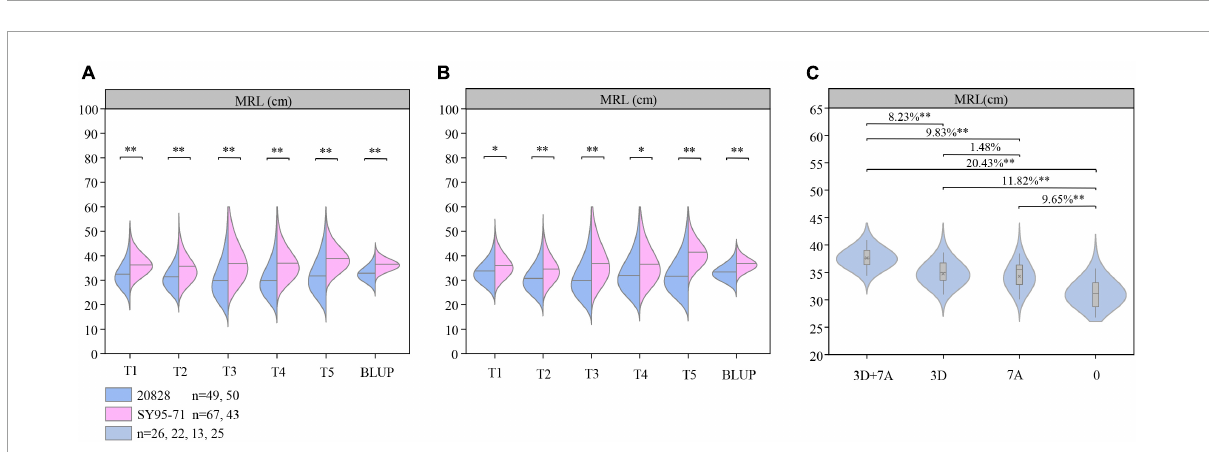
FIGURE5 The genetic effect of major quantitative trait loci (QTL) QMrl.sicau-2SY-3D.2 and QMrl.sicau-2SY-7A.2 . Genetic effects of QMrl.sicau-2SY-3D.2 and QMrl.sicau-2SY-7A.2 in 20828/SY95-71(2SY) population (A,B) . The pyramiding effect of QMrl.sicau-2SY-3D.2 and QMrl.sicau-2SY-7A.2 on maximum root length (MRL) (C) . ∗ and ∗∗ represent significance at the 0.05 and 0.01 level.